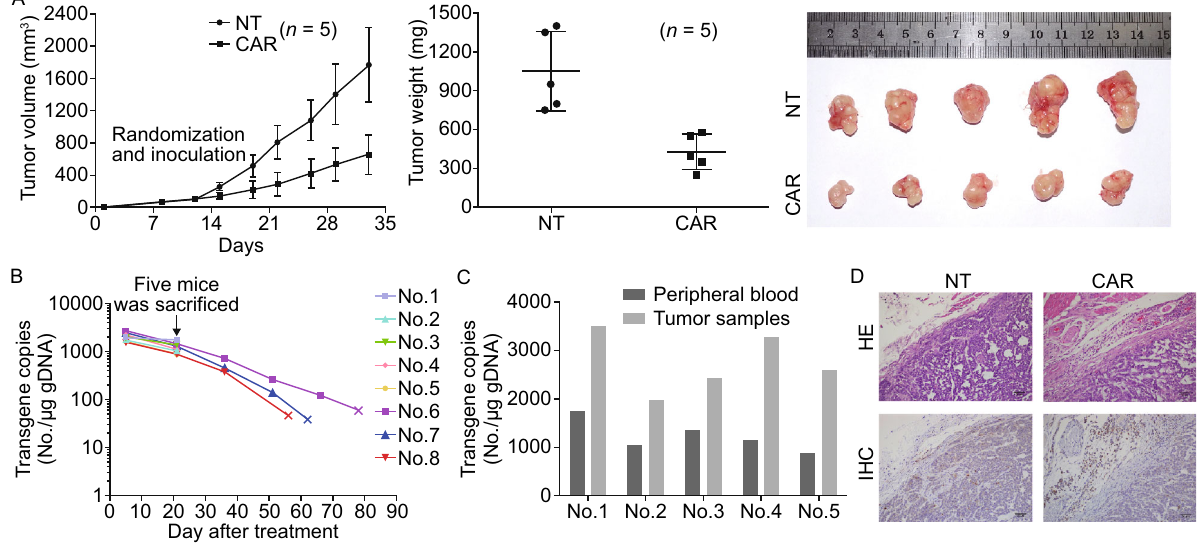
Figure 4. Antitumor ef fi cacy of HER2-directed chimeric antigen receptor T cells against xenografts derived from HER2 + GC cell lines in mice. (A) Two million HER2 high+ 7901 cells were injected subcutaneously into the unilateral axillary region of BALB/c nude mice on day 0. Five HER2 high+ tumor-bearing mice per group were randomly assigned to the CART-HER2 and NT groups before treatment. When the mean tumor volume reached approximately 100 mm 3 on day 12, intravenous treatment with T cells was performed. Mice with maximum tumor diameters over 2 cm were sacri fi ced on day 33. The tumor volume data are represented as mean ± SD (mm 3 ). The tumor weight data are represented as mean ± SD (mg). Images of tumor samples from sacri fi ced mice are shown. (B) The persistence of the infused CART-HER2 cells in the peripheral blood. qPCR was performed at serial time points, after infusion with CART-HER2 cells, to determine the expression levels of CAR in the peripheral blood of mice ( n = 8). (C) Correlations of CAR copy numbers in tumor tissue and blood samples, obtained after the HER2 high+ mice, treated with CART-HER2 cells, were sacri fi ced on day 33. (D) Hematoxylin-eosin (HE) and immunohistochemical (IHC) staining for anti-CD3 were performed on tumor samples from sacri fi ced